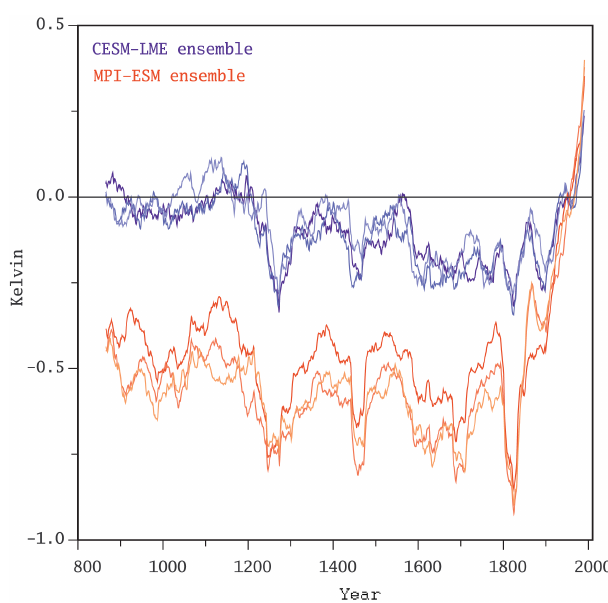
Figure 5. Global mean near-surface air temperature over the past millennium simulated in two ensembles of simulations with the Earth system models MPI-ESM and CESM-LME. The time series represent 31-year running mean of the temperature anomalies rela- tive to the 20th century mean.